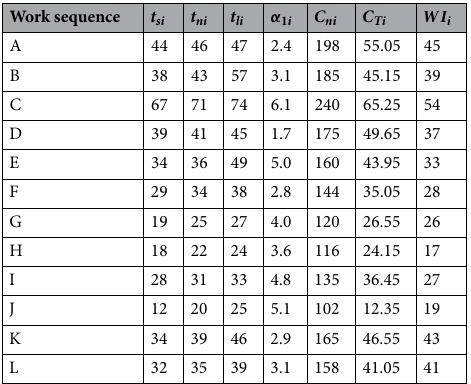
Table 5. Algorithm-related parameters.